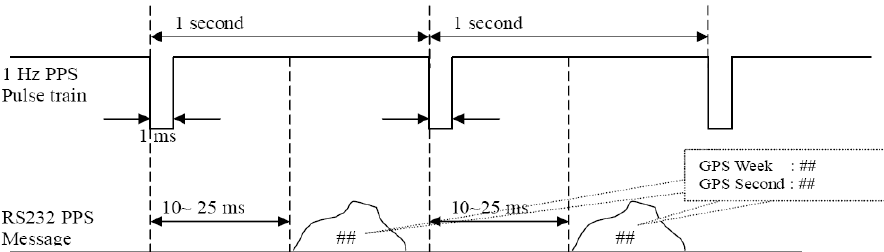
TttT PPSPPSlocalsensor